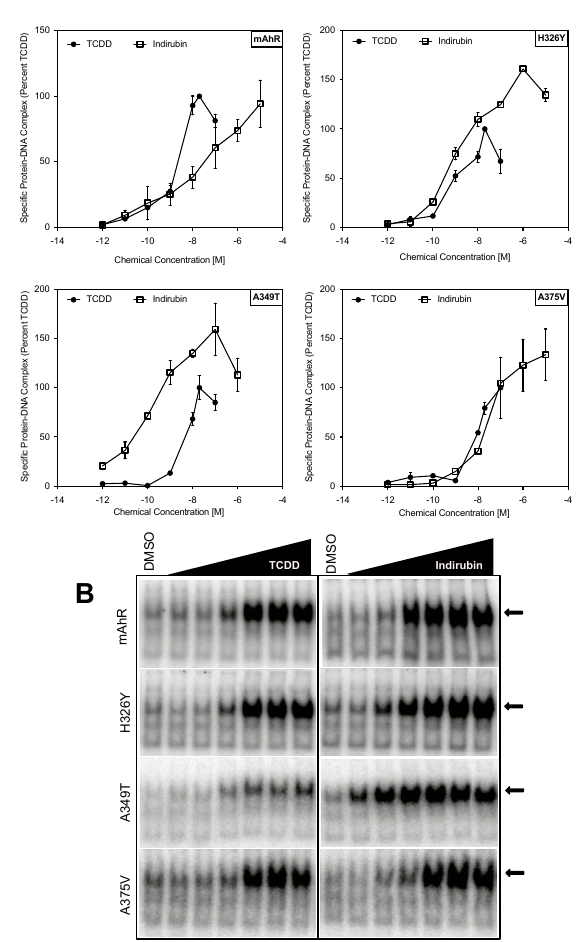
Figure 5. Enhanced signaling of the hAhR by IR is associated with selected residues within the hAhR PASB LBD. In vitro synthesized mutant mAhRs and wild-type mARNT were incubated in the presence of DMSO (1%, v / v ) or AhR agonists in DMSO (TCDD (0.001–100 nM) or IR (0.001–10,000 nM) for 2 h, followed by analysis of AhR DNA binding by gel retardation analysis. ( A ) The amount of inducible protein-DNA complex at each TCDD or IR concentration was quantitated, and values normalized to the amount of complex formed with a maximal activating concentration of TCDD (20 nM). ( B ) Representative gels are shown. Values represent the mean ± SD of nine individual replicate analyses. The arrows indicate the ligand-induced protein-DNA complexes.